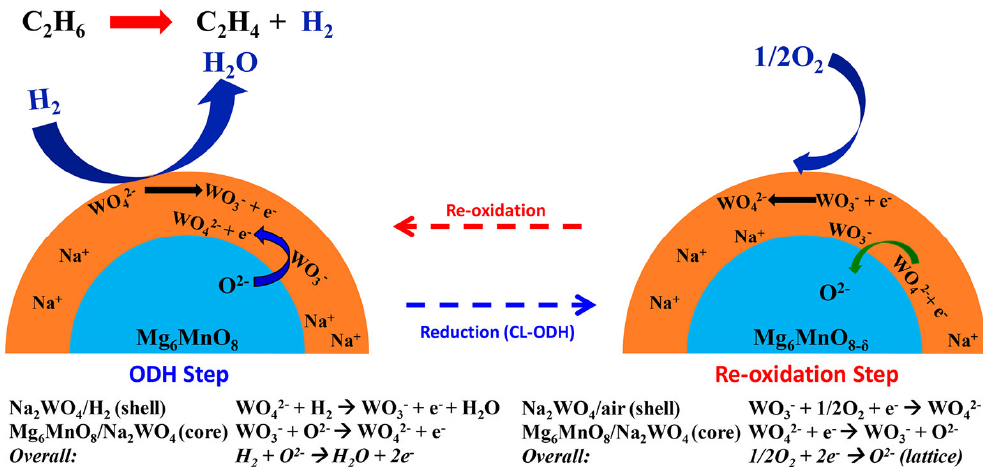
Figure 10. Scheme for oxidative dehydrogenation in a chemical looping manner of ethane over Mg 6 MnO 8 redox catalysts, promoted with NaW (In each step, reduction/oxidation of Mn cations in the Mg 6 MnO 8 core balance the electrons) [69].